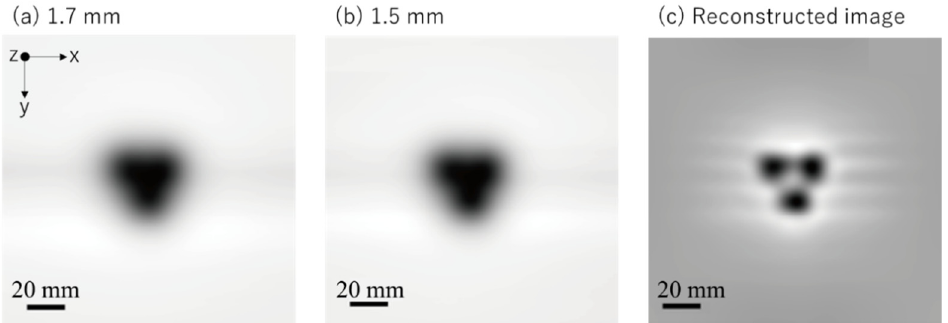
Figure 2. Verification experiments of image reconstruction: magnetic field distribution measured at 1.7 mm ( a ) and 1.5 mm ( b ) above the ferrite magnet sample surface; reconstruction ( c ) based on images ( a , b ).